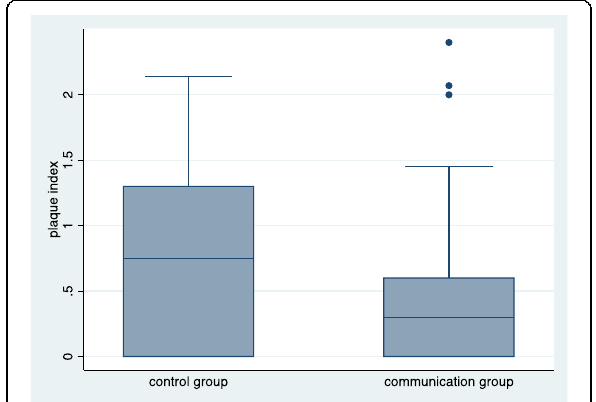
Fig. 2 Box plot of plaque index in the control group and the communication group